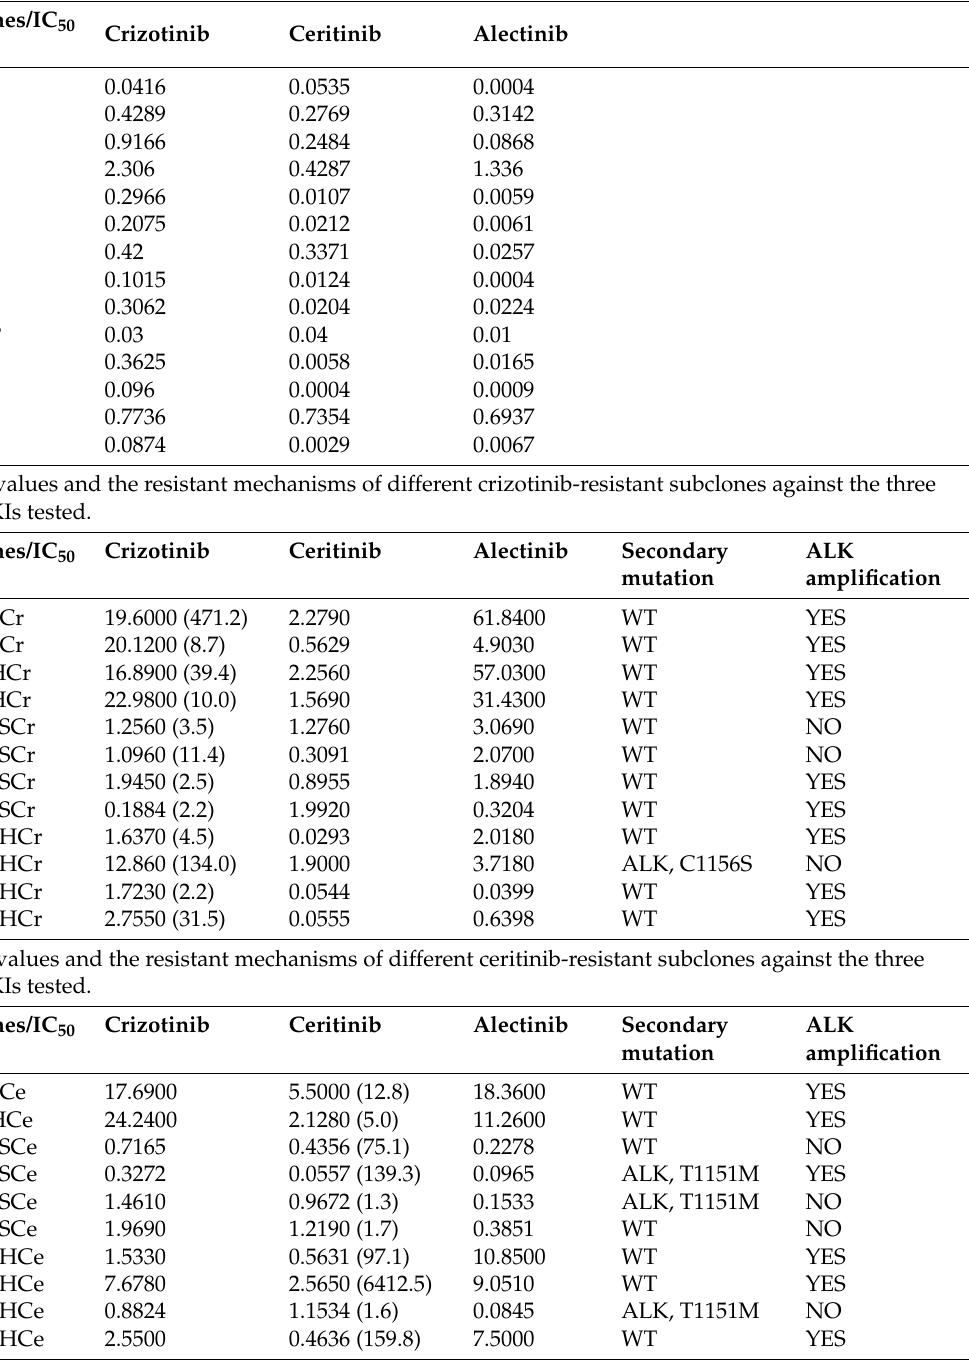
Table 1. IC 50 values of different FA34 and FA121 -parental and -resistant subclones against the three ALK-TKIs tested. ( A ) The FA34 and FA121 subclones were incubated with crizotinib, ceritinib or alectinib (1 nM to 100 µ M) for 72 h. Cell viability was determined by 3-(4,5-dimethylthiazol-2-yl)-2,5- diphenyltetrazolium bromide (MTT) assays. The ( B ) crizotinib or ( C ) ceritinib resistant subclones of FA34 and FA121 were treated with crizotinib, ceritinib or alectinib (1 nM to 100 µ M) for 72 h. Cell viability was determined by MTT assay. The values in brackets indicate the fold-changes in IC 50 compared with the respective subclones before prolonged TKI exposure. For secondary mutations, the ALK kinase domain was amplified and was sequenced to detect secondary mutations. Presence of ALK amplifications in these resistant subclones was determined by qRT-PCR. Wild-type (WT). A. IC 50 values of different FA34 and FA121 subclones against the three ALK-TKIs tested